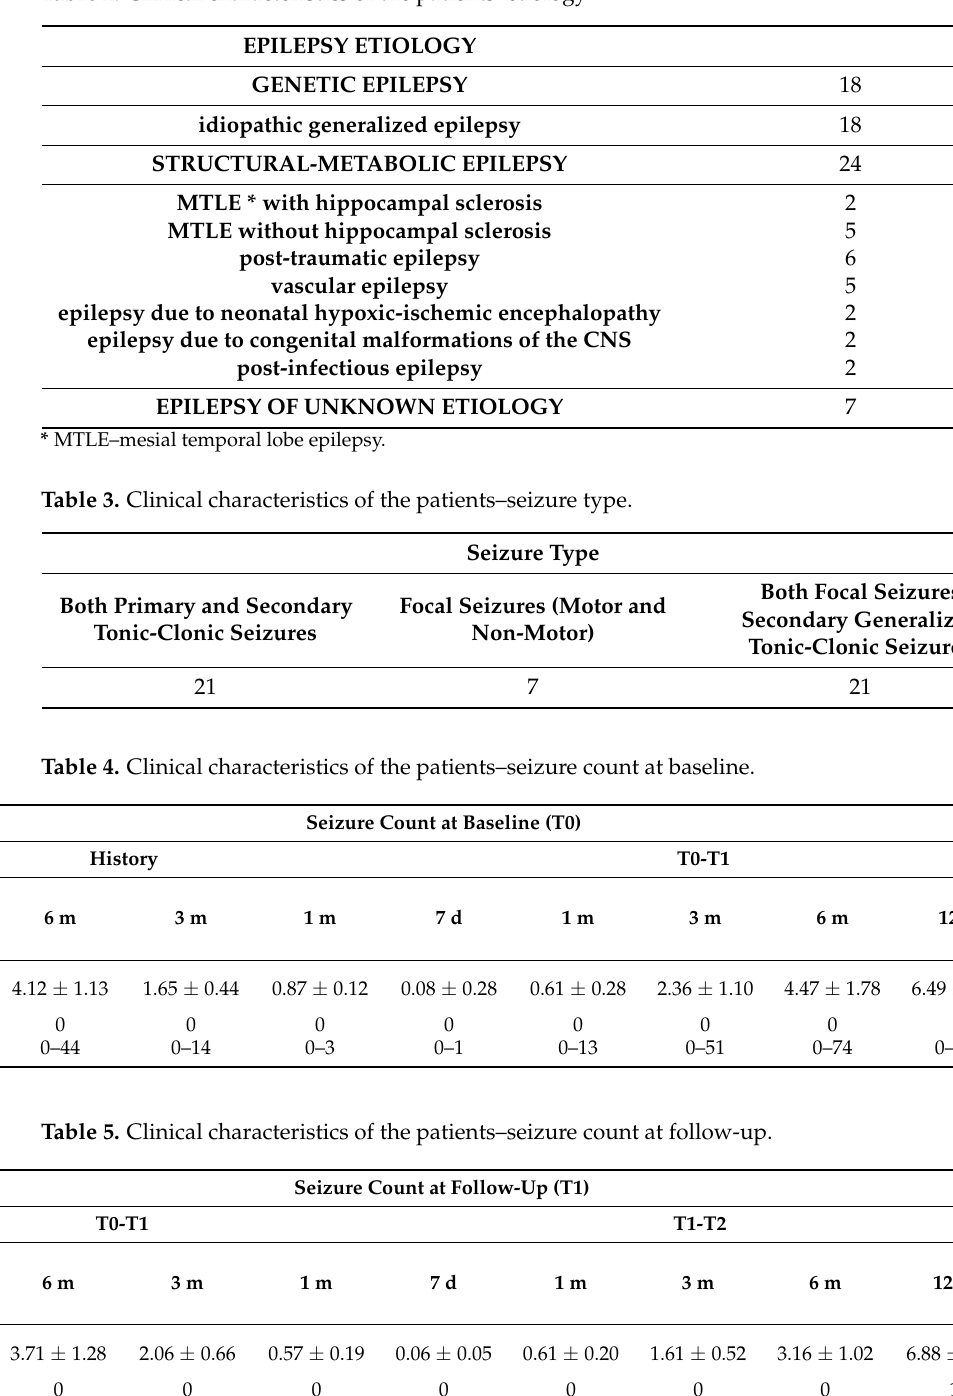
Table 2. Clinical characteristics of the patients–etiology.